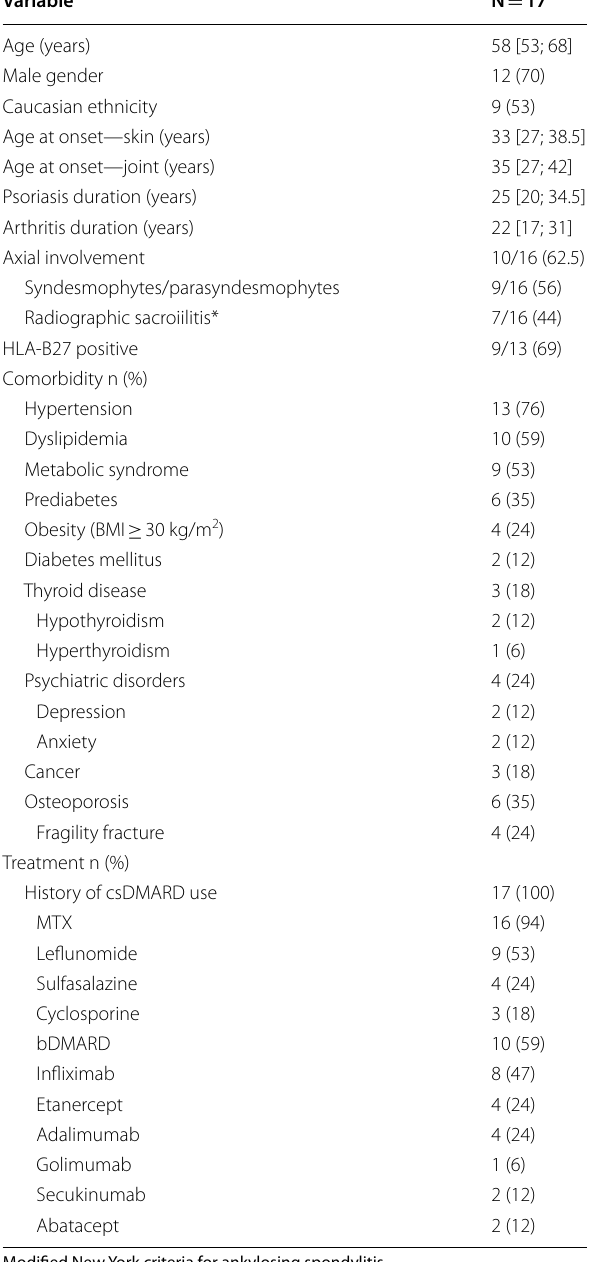
Table 1 Characteristics of PsA patients with arthritis